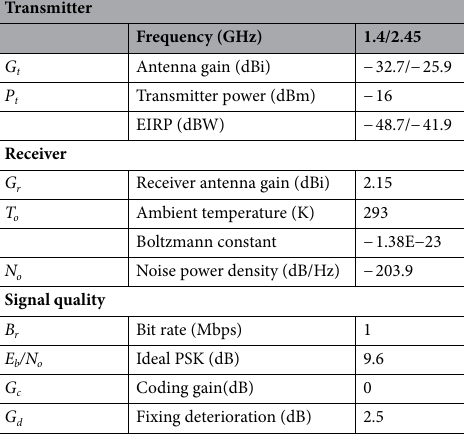
Table 5. Link budget parameters.